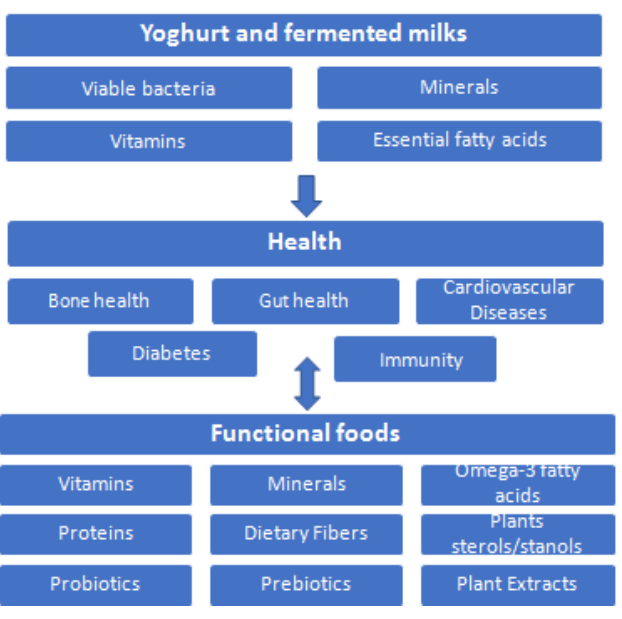
Figure 7. Health benefits of yoghurt and fermented milks, leading to ideal vehicle for functional